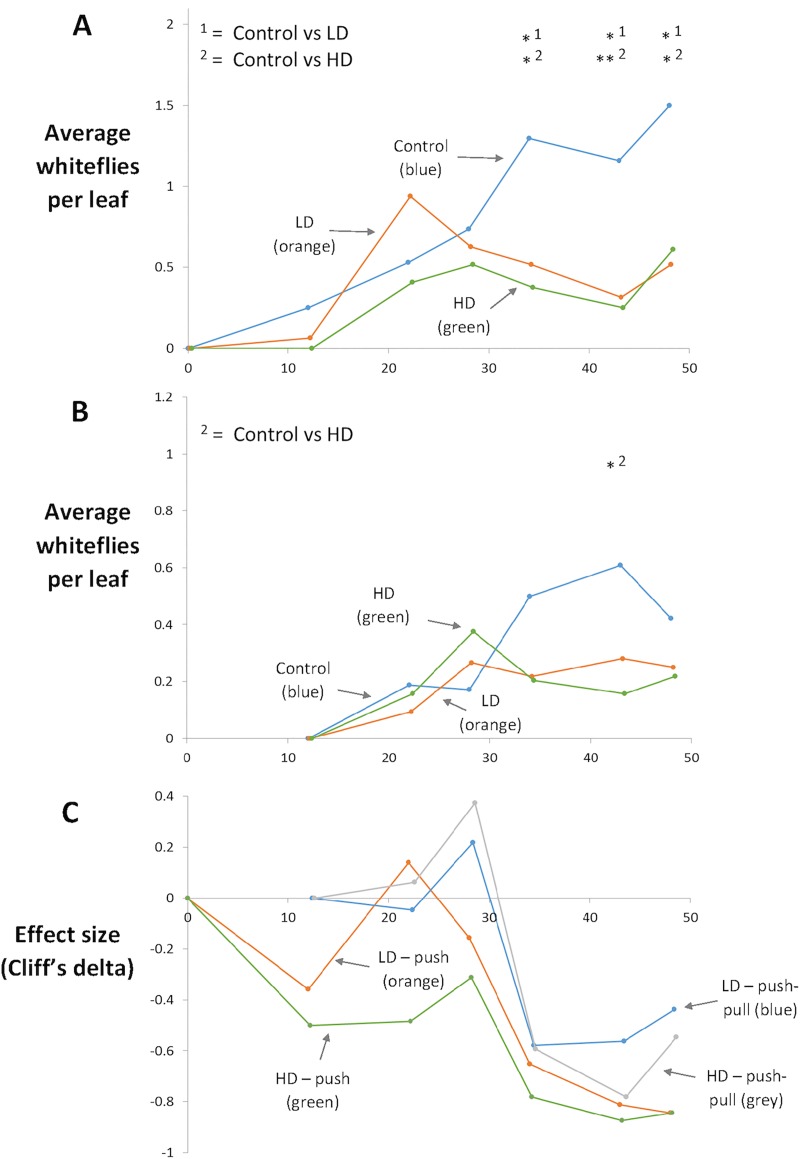
Population development of the whitefly, T. vaporariorum on tomato in the glasshouse, with all whitefly life stages (adult, eggs and nymphs) contributing to the average number of whitefly/leaf (n = 8).Day 0 is 10th August 2016 and the ‘push-pull’ was started 12 days after the “push” experiment. Whitefly abundance data from Fig 1A and 1B was (log +1) transformed and analysed over time with repeated measures ANOVA’s and Bonferroni corrected post-hoc comparisons, in which the p values were multiplied by the total number of comparisons (n = 3). Significant observations between treatments at individual sampling points are annotated onto the graphs with asterisks, “*” indicates a p value of <0.05, “**” p <0.001. All other p values were non-significant at α = 0.05. Fig 1A Shows the “push” experiment in which repellent plants such as marigold (LD) and marigold plus non-hosts (HD) are intercropped amongst tomato plants. There was a significant effect of the treatment (rm ANOVA F
(2,126) = 18.85, p < 0.001) and treatment x time (rm ANOVA F
(10,126) = 2.14, p = 0.025) across the sampling period. Fig 1B Shows the ‘push-pull’ experiment which is the same as the ‘push’ experiment but additionally a single (LD) and several (HD) host plant species surround the repellent hosts and tomato. There was a significant effect of treatment (F
(2,105) = 3.73, p = 0.027) but no significant effect of treatment x time (F
(8,105) = 1.49, p = 0.166) following repeated measures ANOVA’s. Post-hoc comparisons from Fig 1A showed there were significantly less whiteflies in LD and HD plots at day 34 (LD, t = 2.89, df = 126, p = 0.013. HD, t = 3.61, df = 126, p = 0.001), day 43 (LD, t = 3.59, df = 126, p = 0.001. HD, t = 3.92, df = 126, p < 0.001) and day 48 (LD, t = 3.66, df = 126, p = 0.001. HD, t = 3.29, df = 126, p = 0.003). For Fig 1B, there were significantly less whiteflies on the HD treatment at day 43 (t = 3.018, df = 105, p = 0.009) but not on the LD treatment (t = 2.20, df = 105, p = 0.088). Fig 1C shows the data in Fig 1A and 1B expressed as effect size (relative to control). The Cliff’s d measure is used as this is suitable for non-normal data of the type observed in experiments. Values of 1 or -1 (the sign shows the direction of effects relative to control) indicate complete non-overlap between the groups under consideration and a value of 0 indicates complete overlap. Ninety five percent confidence intervals have been calculated and are available in the supporting information (S1 Dataset), but to aid visualisation they have been removed from the figure.